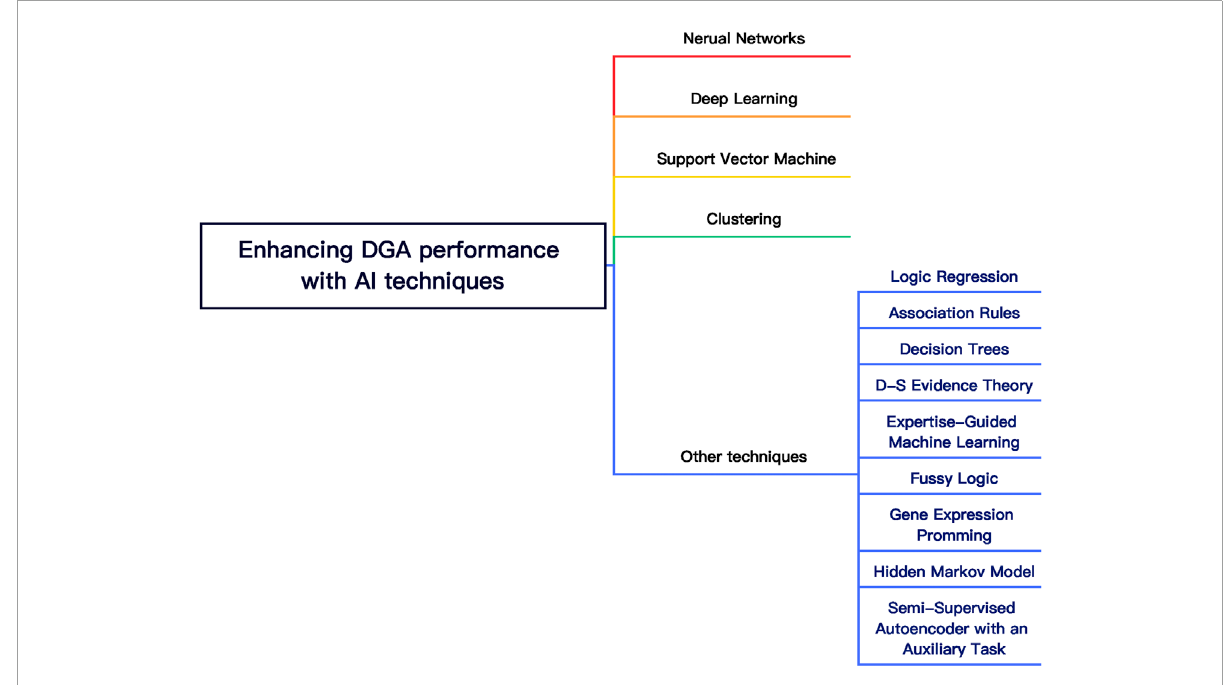
FIGURE 1 Enhancing DGA performance with AI